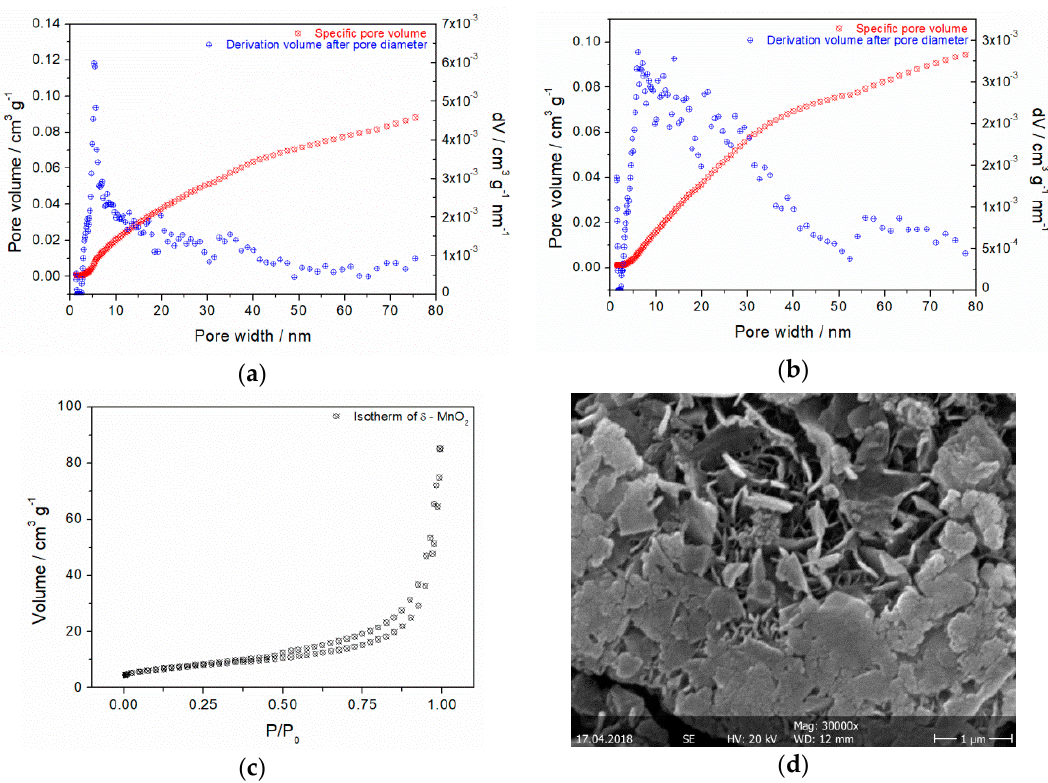
Figure 6. Pore size distribution of δ -MnO 2 (14 h @ 110 °C in 1.6 M KOH) computed with NLDFT cylindrical pore equilibrium model on silica ( a ), cylindrical pore adsorption branch model ( b ), N 2 desorption/adsorption isotherms at 77 K for synthesized δ -MnO 2 after 28.2 h degassing at 150 ◦ C, measuring time 11:41 h:min ( c ) and SEM image of δ -MnO 2 ( d